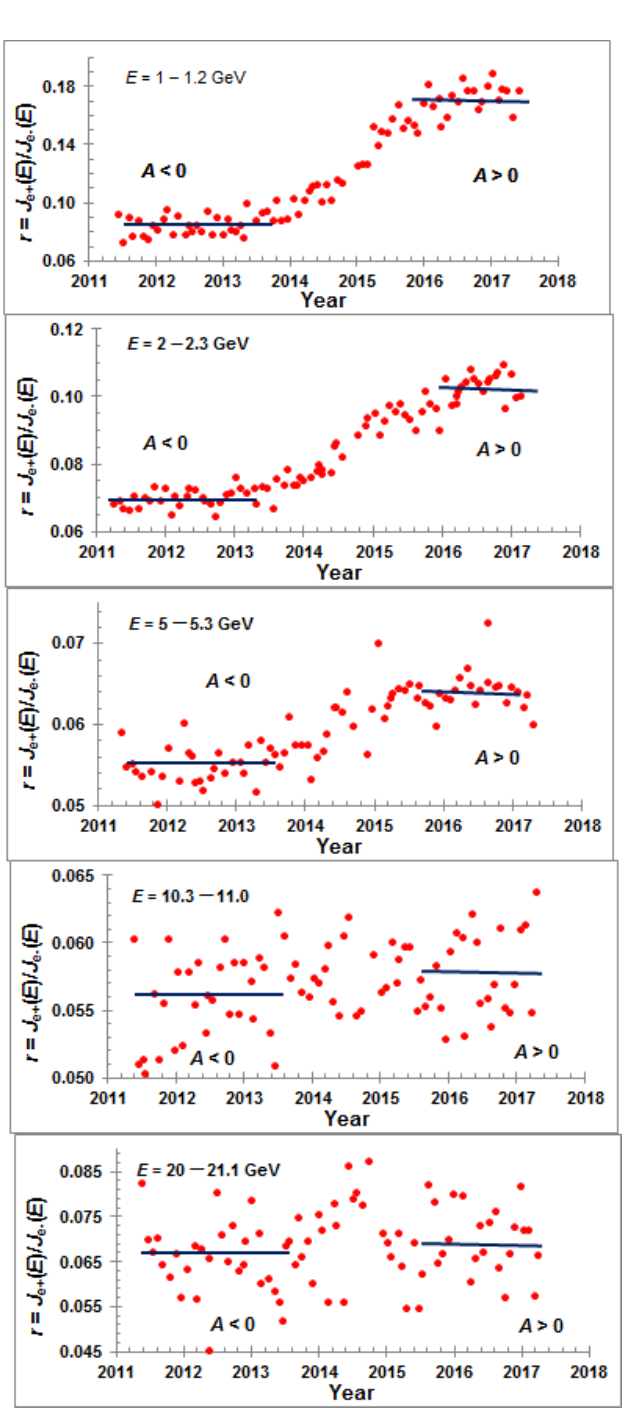
Figure 6. The ratio of positron intensity to electron intensity as a function of the time and energy of these particles, r ( E, t ) = J e+ ( E, t )/ J e- ( E , t), where J e+ ( E, t ) and J e- ( E , t) are the intensities of positrons and electrons, correspondingly [9]. Dark horizontal lines show the average values of r before the beginning (the middle of 2013) and after the end (the end of 2015) of the inversion of magnetic field in the heliosphere.